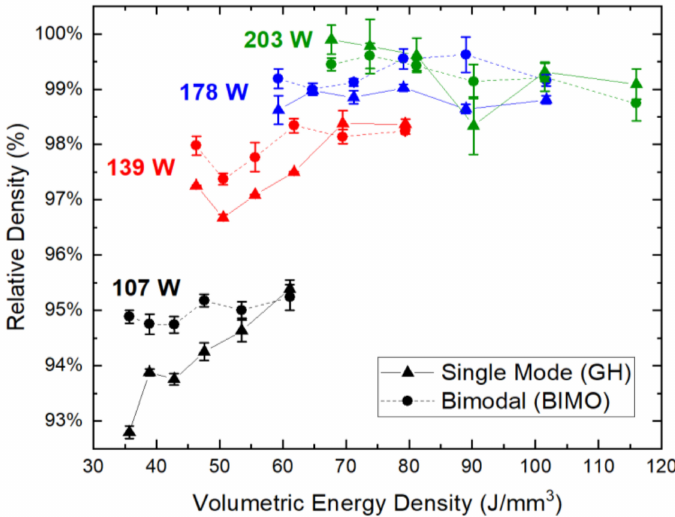
Figure 4. Relative density of 316L SLM-manufactured samples as a function of VED for single-mode (GH) and bimodal feedstock powder (BIMO), categorized by power level. For each power level, scan speed ranges from 700 to 1200 mm /